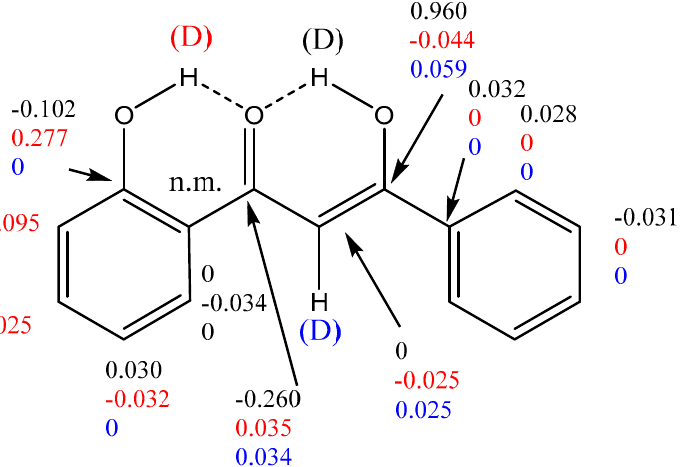
Figure 3. Deuterium isotope effects on 13 C chemical shifts. They are defined as n Δ = δ Cx(H) - δ Cx(D). n is the number of bonds between the label (deuterium) and the nucleus in question, Cx. The isotope effects given are color-coded to refer to the deuterium causing the effect. Data were taken from [11] with permission from Elsevier.